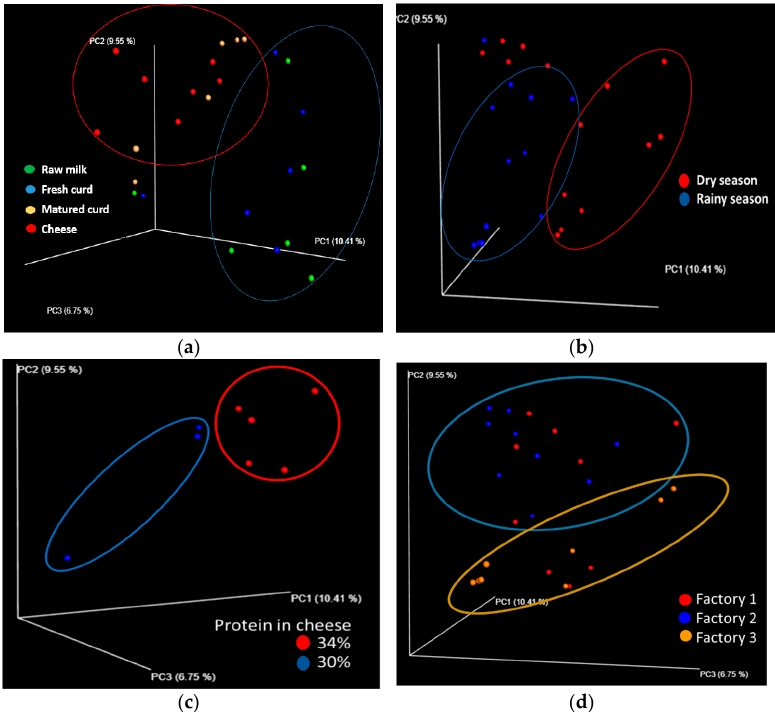
Figure 2. Beta diversity for artisanal Adobera cheese samples shown in a principal coordinates chart from: ( a ) different stages of preparation and two seasons. The letter Q represents the cheese factory number; letter T the season of the year (T1 = dry season, T2 = rainy season). Raw milk = raw milk; Fresh curd = fresh curd; Matured curd = ripened or acidified curd; Cheese = cheese as a finished product ( b ) Dry and rainy seasons ( c ) different protein content in cheese, and ( d ) three different cheese factories.